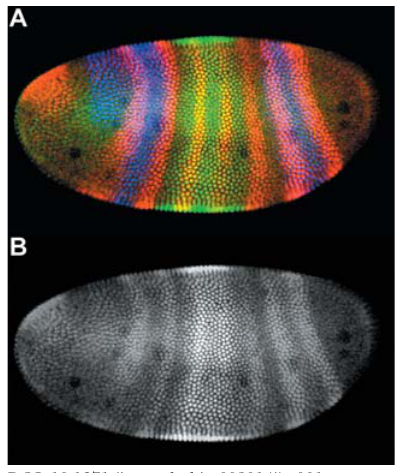
Figure 1. Comparison of Published and Photocopied Figures Example of an image that, when seen in color (A), is rich with information; much of this information is lost when it is photocopied by students (B), as when the original is held on reserve in the library, as is required for subscription-based journals, or is provided via interlibrary loan. This image of a developing fl y embryo was labeled to reveal bands of differentially expressed proteins, with HAIRY in red, KRÜPPEL in green, and GIANT in blue. (Image courtesy of Stephen W. Paddock, Jim Langeland, and Sean Carroll at the University